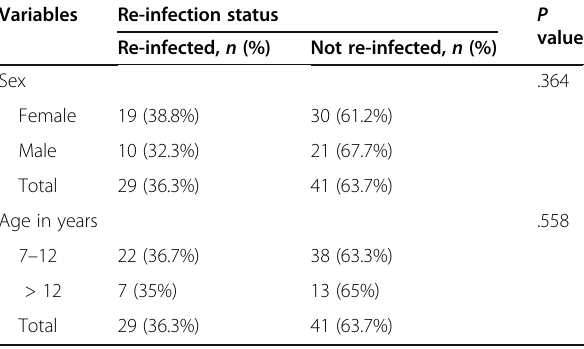
Table 4 Association of sex and age with re-infection rates of STH among schoolchildren in Northwest Ethiopia ( n = 80)